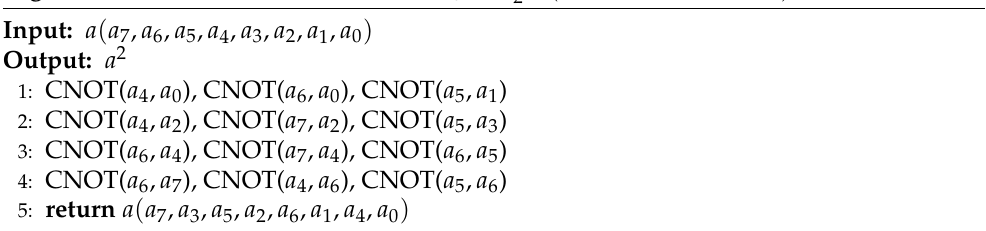
/ ( x 8 + x 4 + x 3 + x + 1 ) 2 8